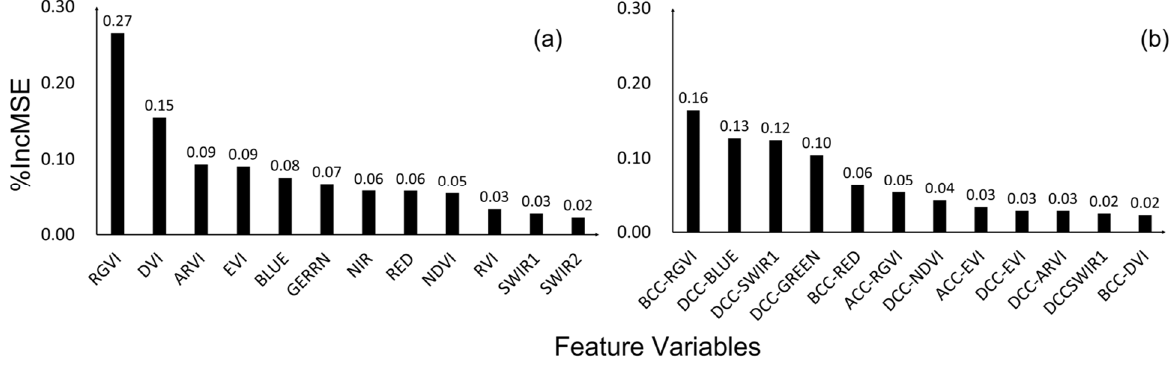
Figure 7. The importance of spectral variables: ( a ) is variables extracted from single LC8 images; ( b ) is variables extracted from composite LC8 images.